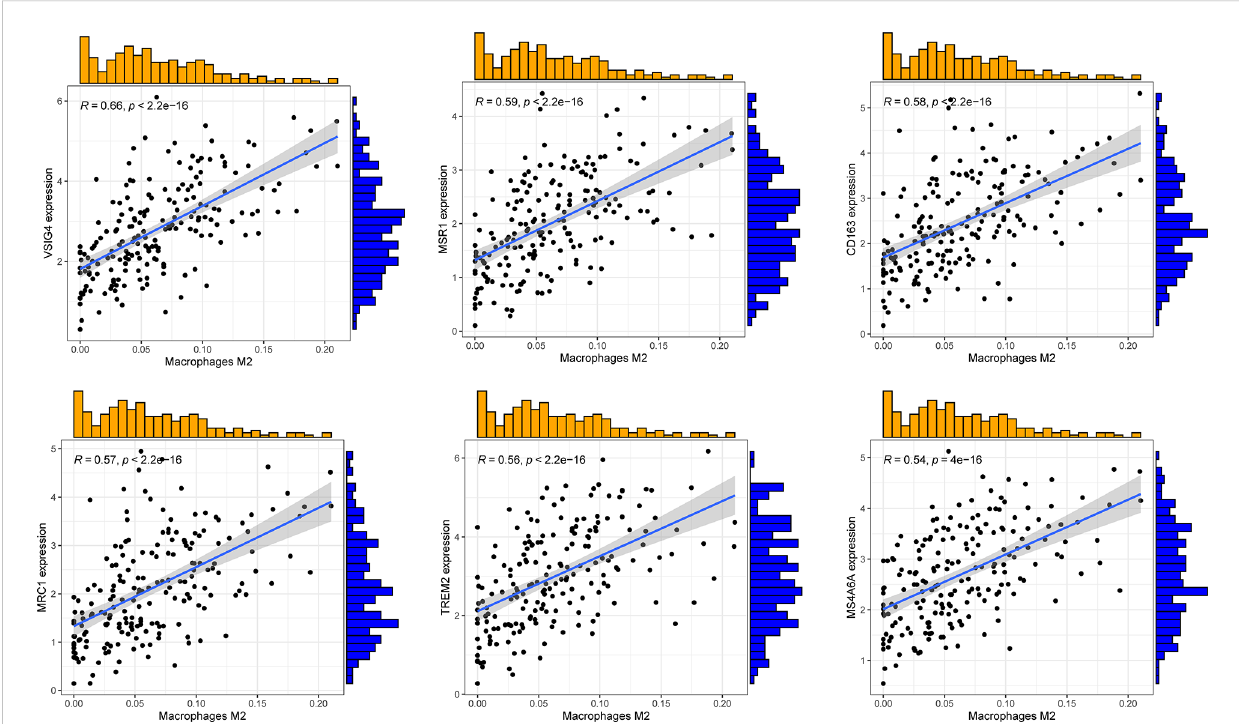
FIGURE 2 Correlation maps of the top 6 genes associated with M2 macrophage in fi